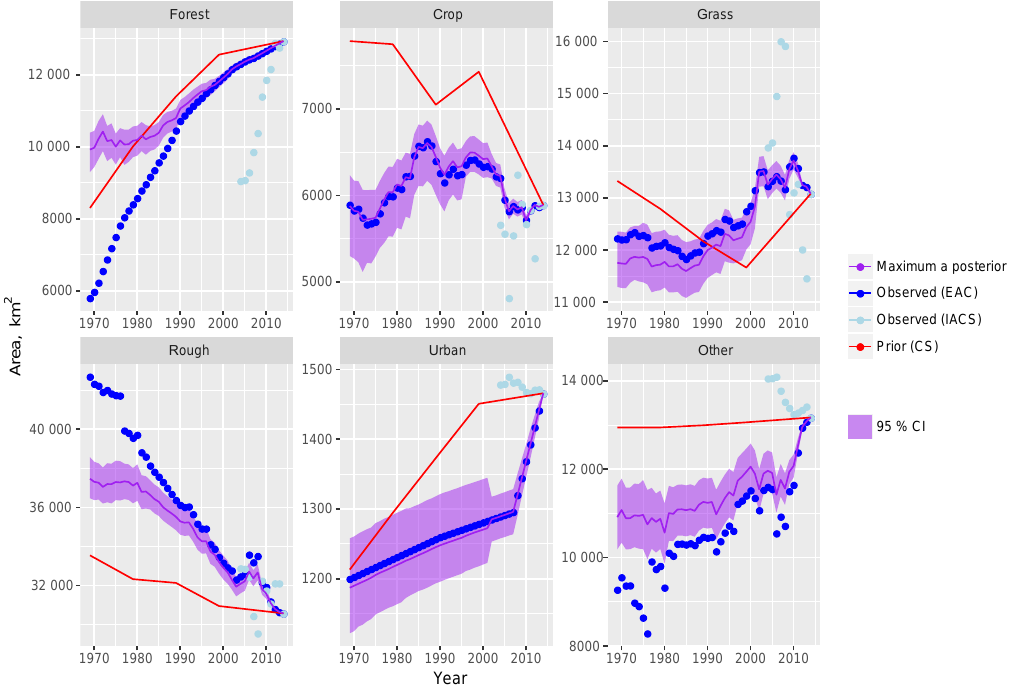
Figure 4. Time series of the area occupied by each land use ( A ut ) from 1969 to 2015, showing the observations, prior, and posterior estimates. The shaded band shows the 2.5 and 97.5% percentiles of the posterior distribution of the net change in